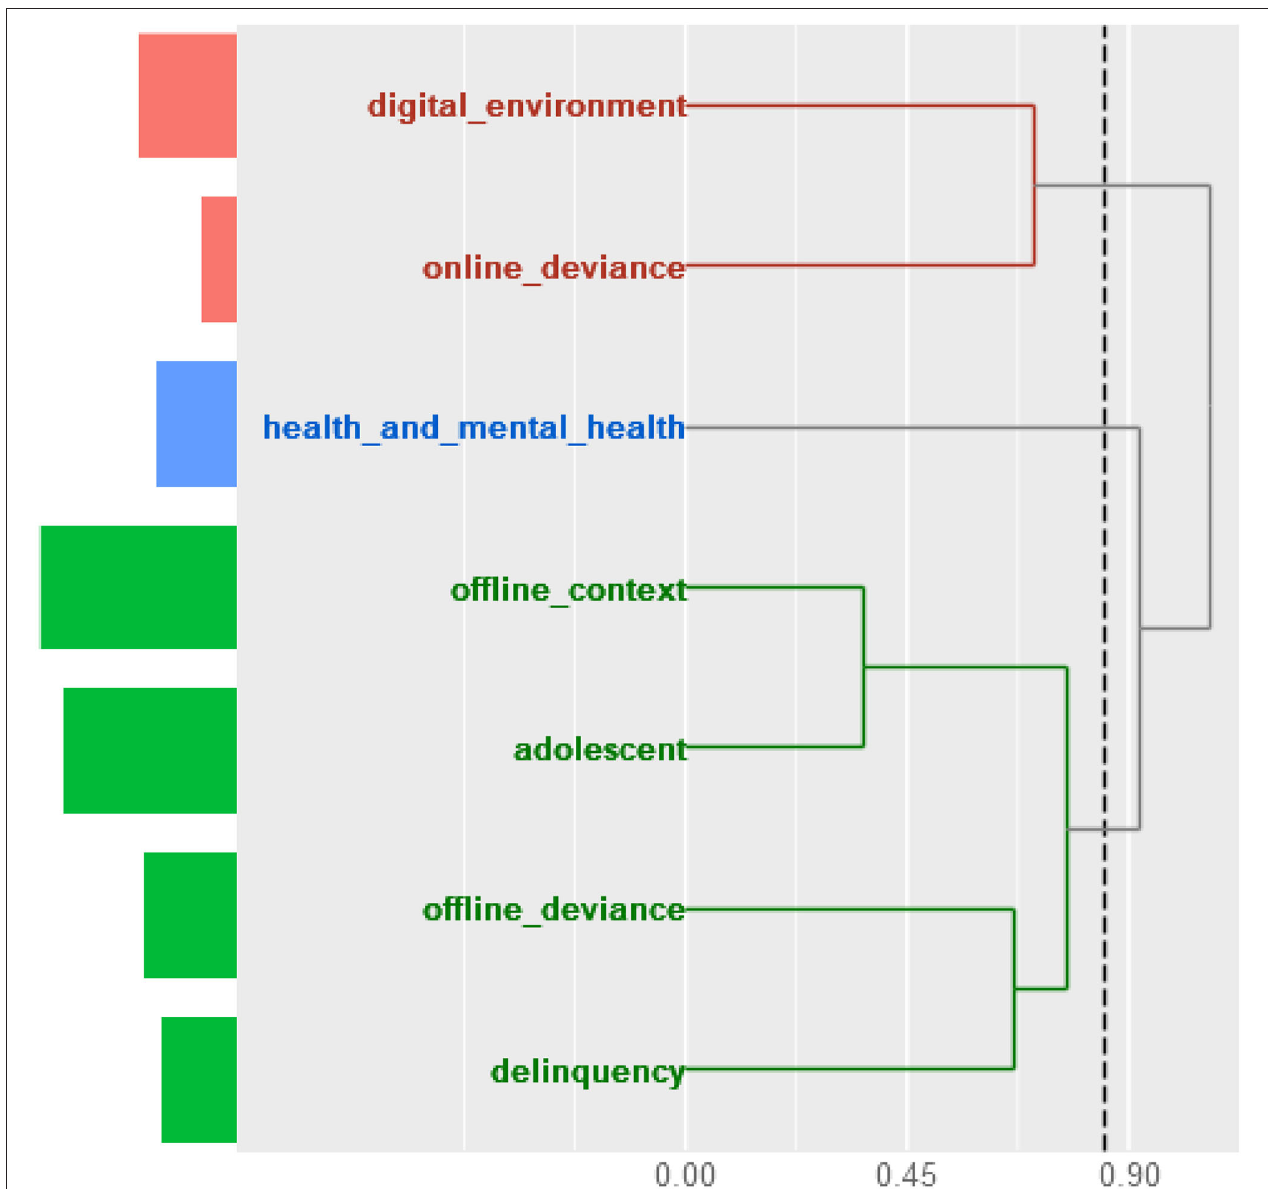
FIGURE 2 | Hierarchical cluster analysis of the preliminary